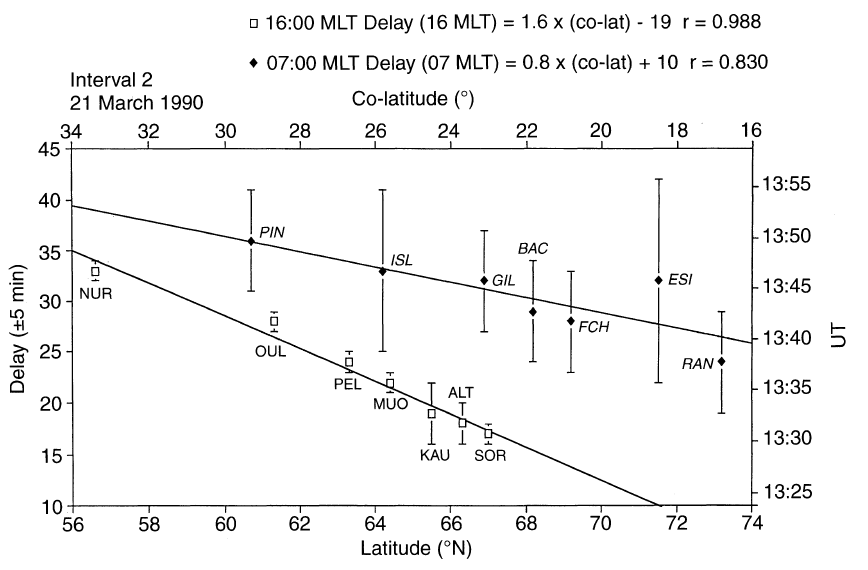
Fig. 8. Response times to the southward turning as a function of latitude at 1314 ((cid:139)5) UT on March 21 during interval 2 measured by seven ground magnetometer stations at 1600 MLT ( square symbols ) and seven stations at 0700 MLT stations ( solid diamond symbols )